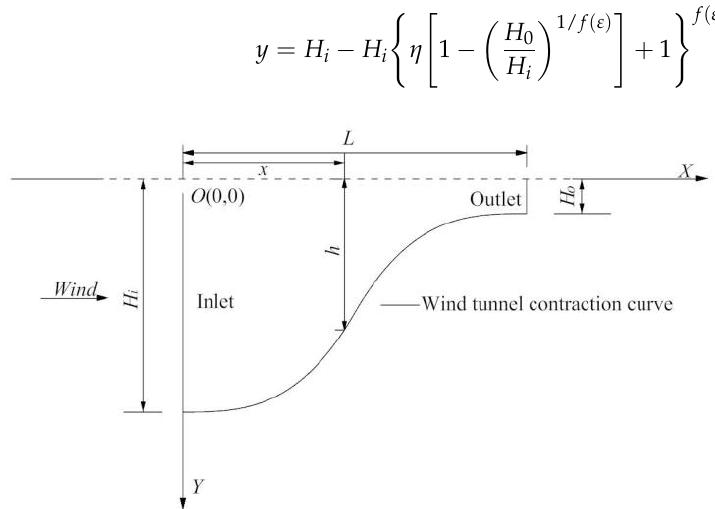
Figure 2. Wind tunnel contraction curve.